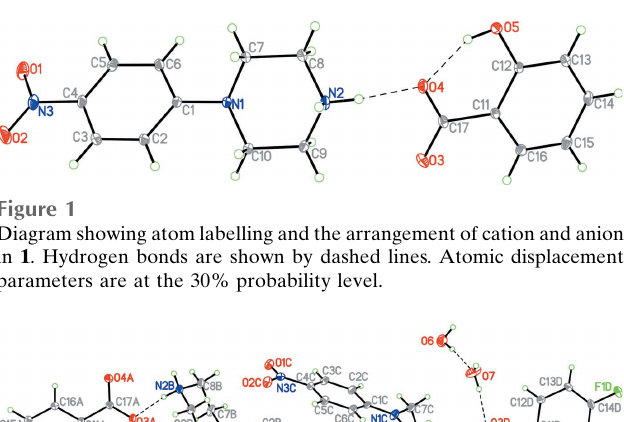
Table 1]. In the salicylate anion, there is an intramolecular